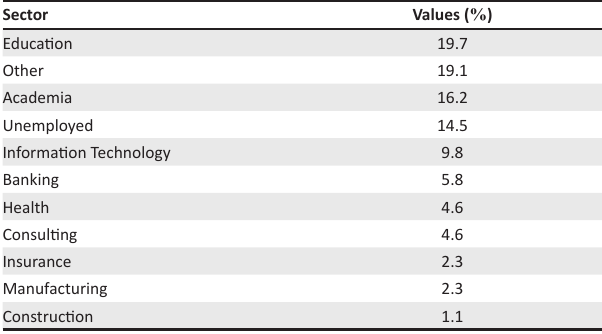
TABLE 2: Sector or occupation analysis.